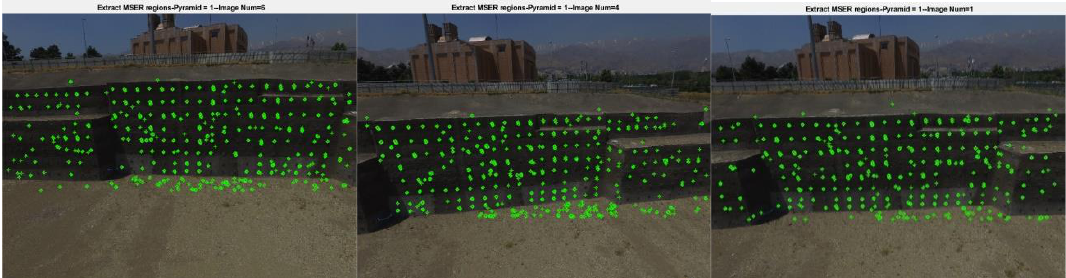
Figure 14. Sample results of local feature extraction from the UAV-captured images from the Seoul excavation project.